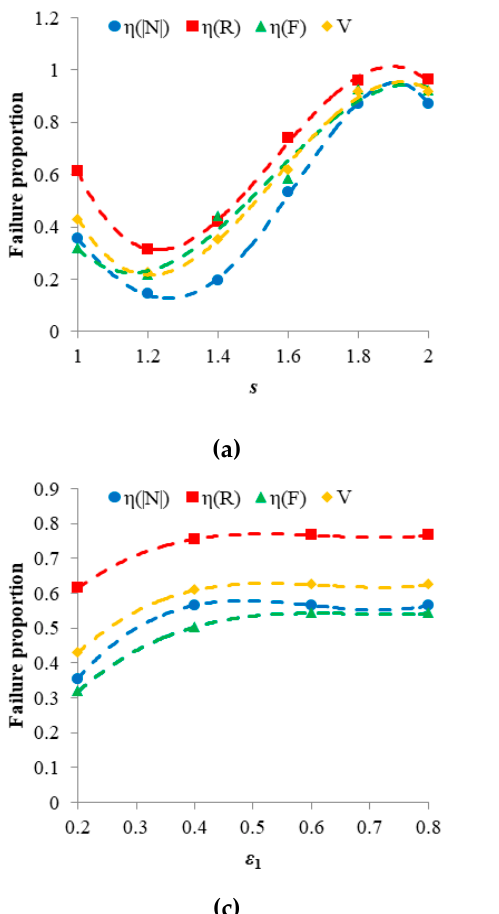
Figure 12. The change of η (| N |), η ( R ), η ( F ) and V changes with s , α , ( b ) s = 1.0, ε 1 = ε 2 = 0.2; ( c ) s = 1.0, α = 0.3, ε 2 = 0.2; ( d ) s = 1.0, α = 0.3, ε 1 = 0.2. Data is derived from Figures 8–11 and Table